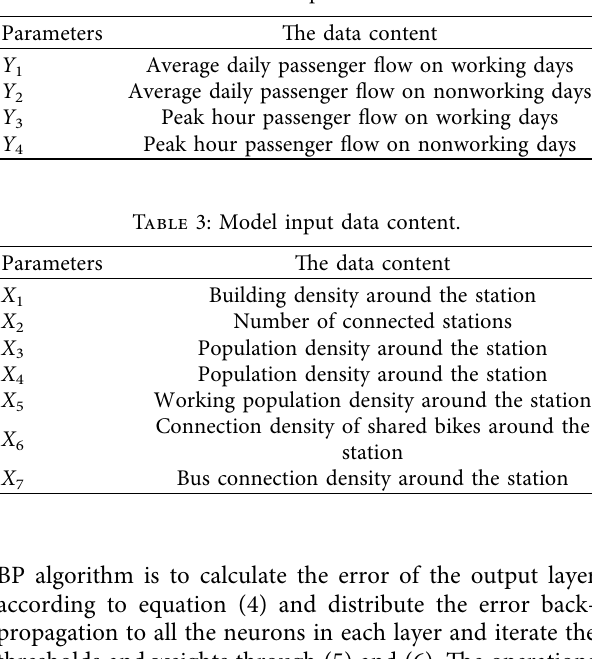
Table 2: Model output data